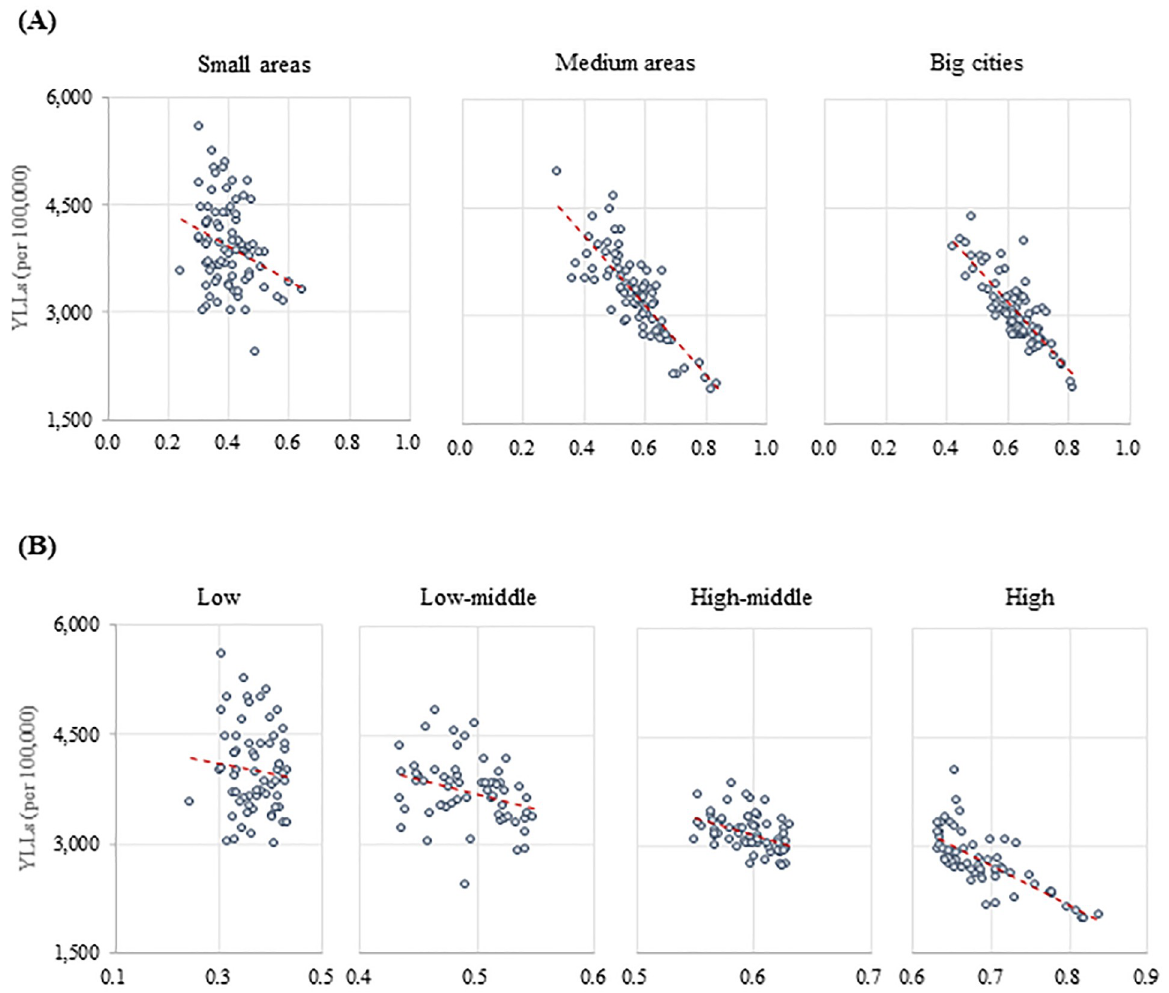
Fig 3. Correlation between K-CHDI and YLLs by subgroups. (A) Regions, (B) K-CHDI-quartiles. K-CHDI = Korean Community Health Determinants Index; YLLs = years of life lost;